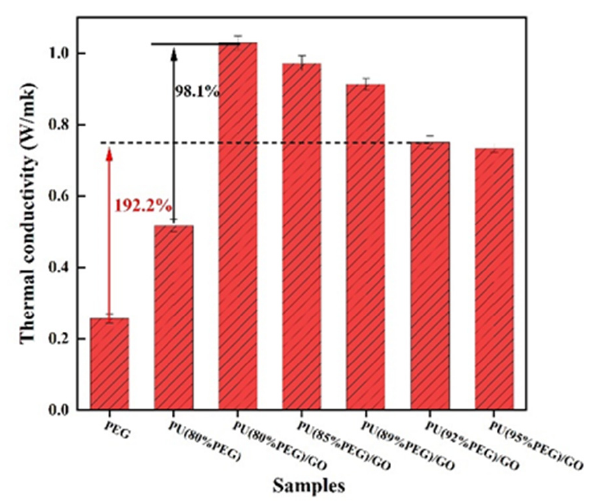
Figure 7. Thermal conductivities of PU and PU/GO.